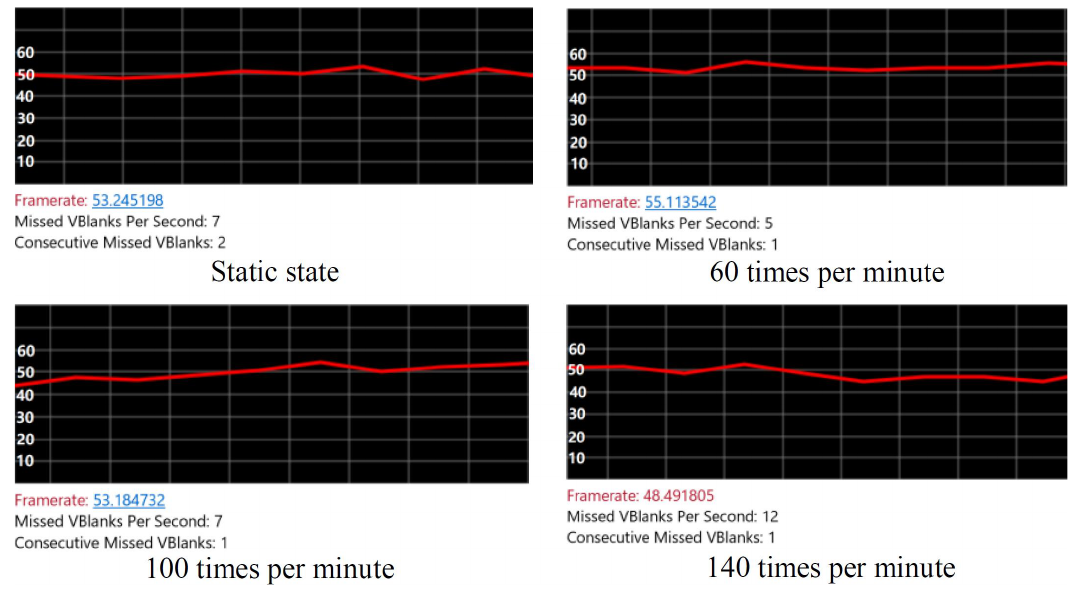
Figure 16. Frames per second (FPS) test results.